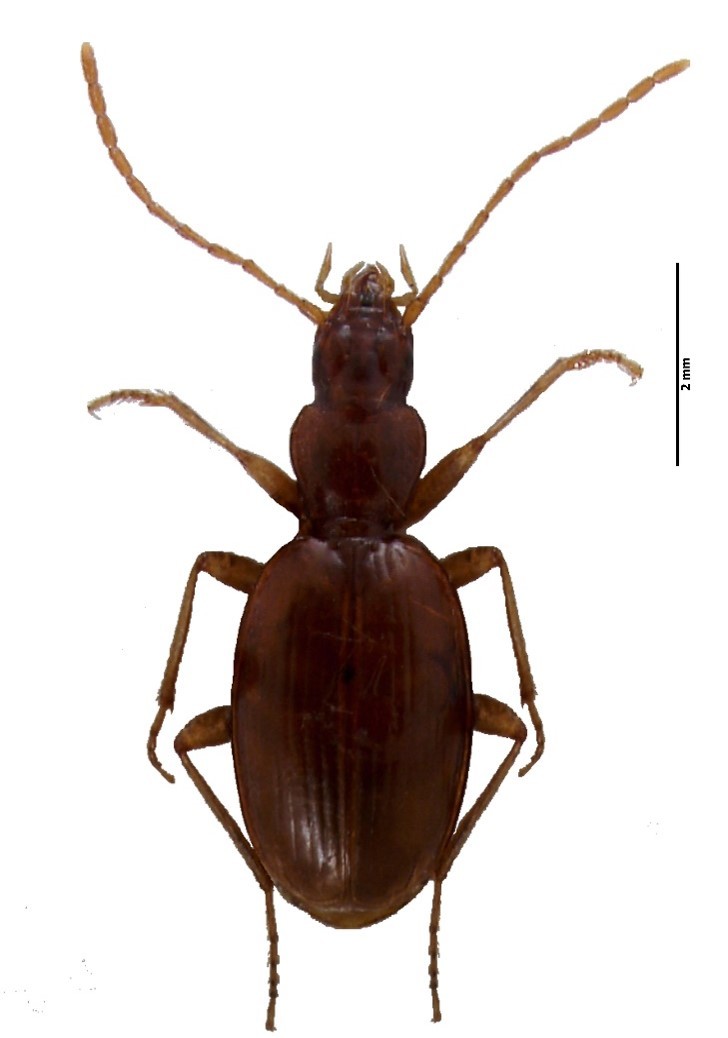
Trechus
oromii (Borges, Serrano & Amorim, 2004) from Faial island (Azores, Portugal) (Credit: Enésima Mendonça, Azorean Biodiversity Group, cE3c).